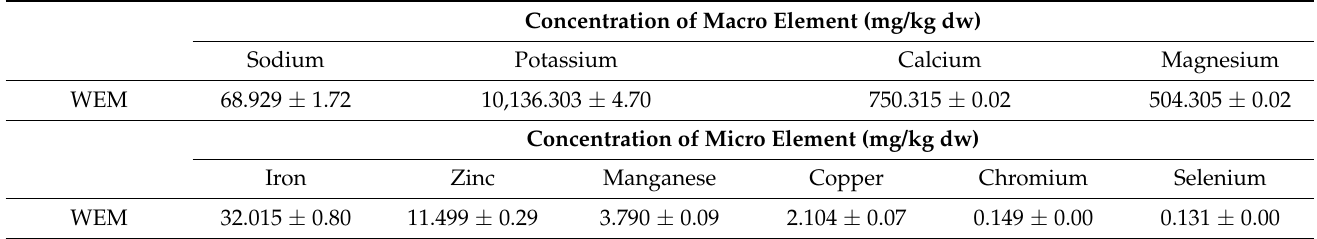
Table 3. The mineral content of WEM ( A. cornea